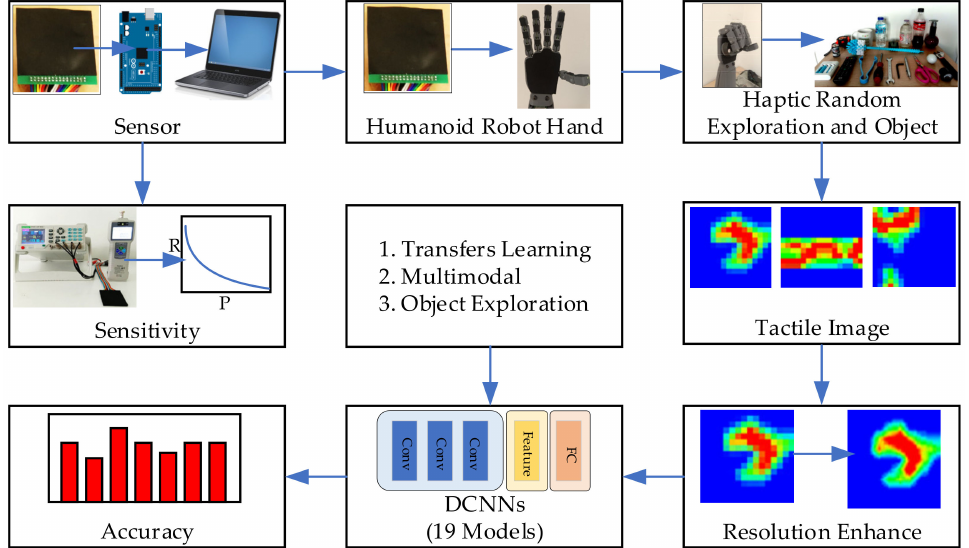
Figure 1. Proposed block diagram of tactile object recognition for the humanoid robot using DCNN.